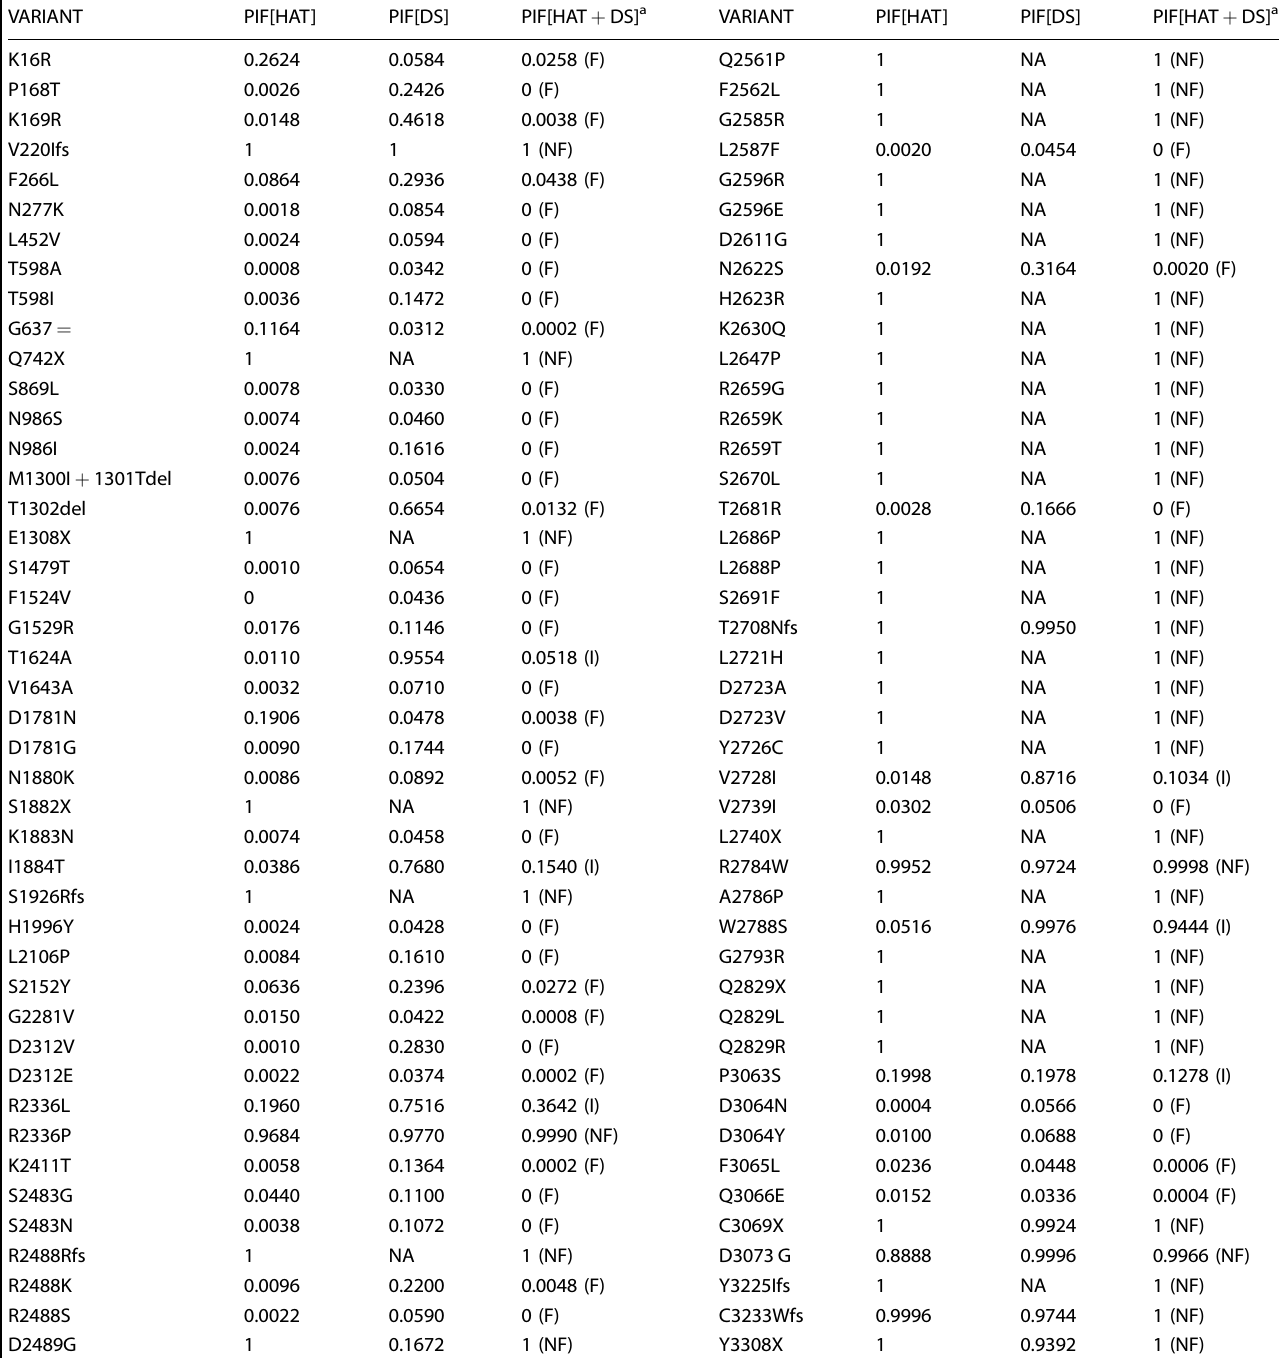
Table 1. Probability of impact on function (PIF) of variants based on cell survival (HAT) and drug sensitivity (DS) assay results individually and combined (HAT +